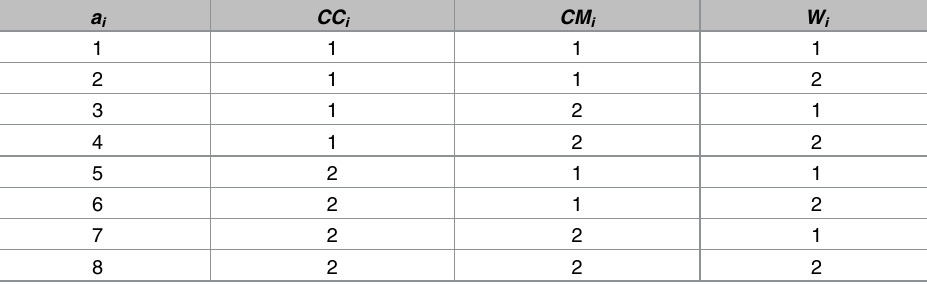
Table 5. Encoding of the 8 possible actions when field i is a canola